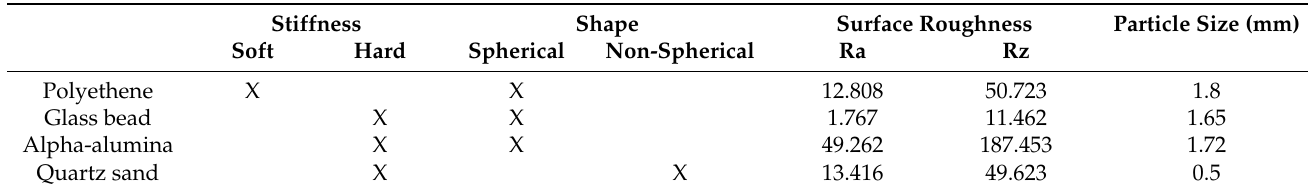
Table 1. Classification of primary particles used in experiments according to their properties.